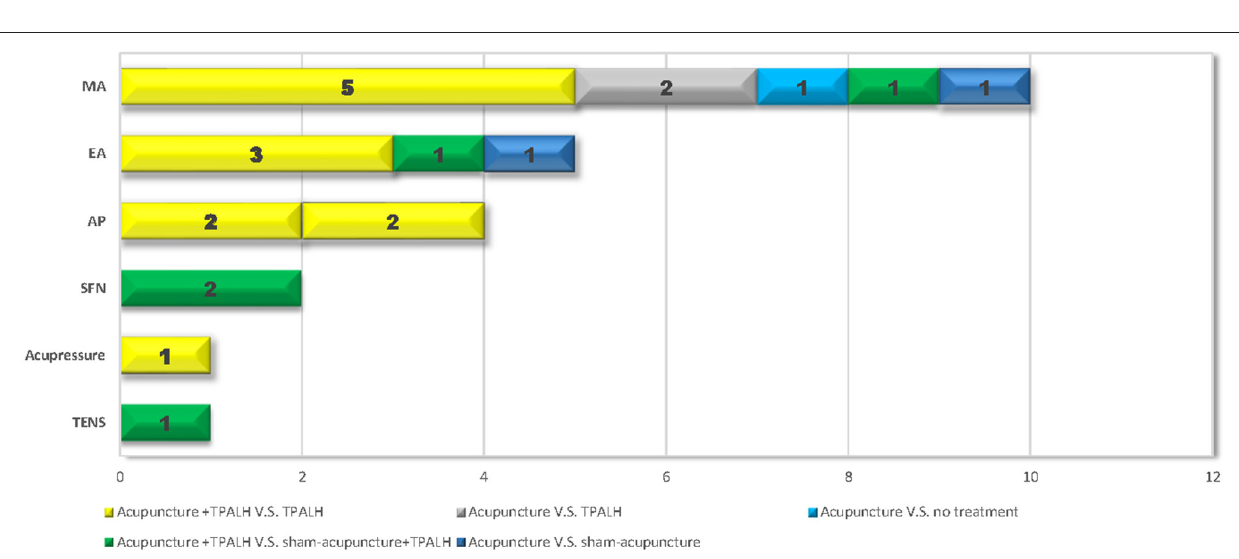
FIGURE 6 | Categories of included